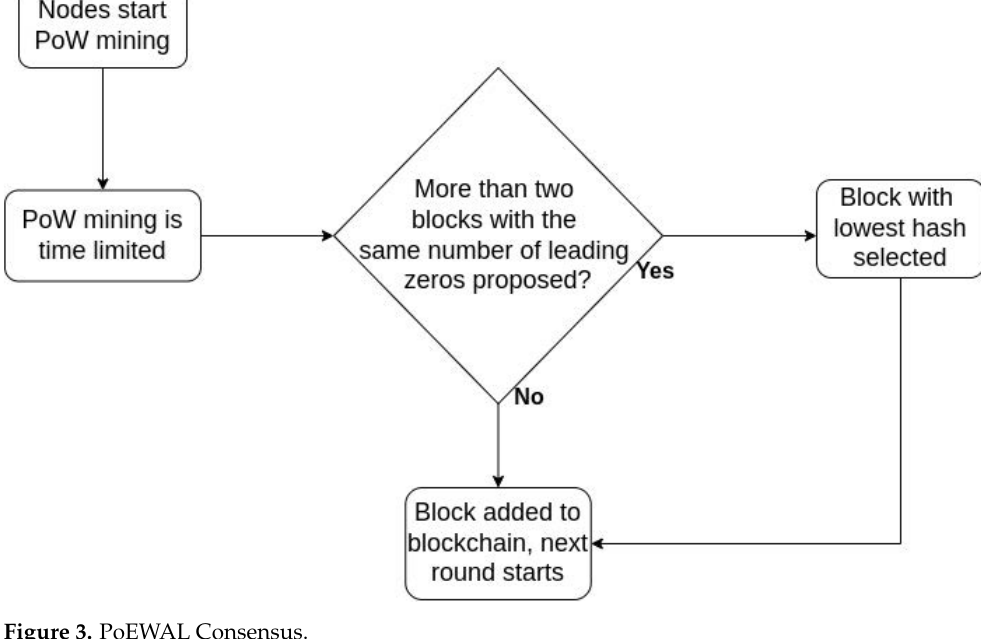
Figure 3. PoEWAL